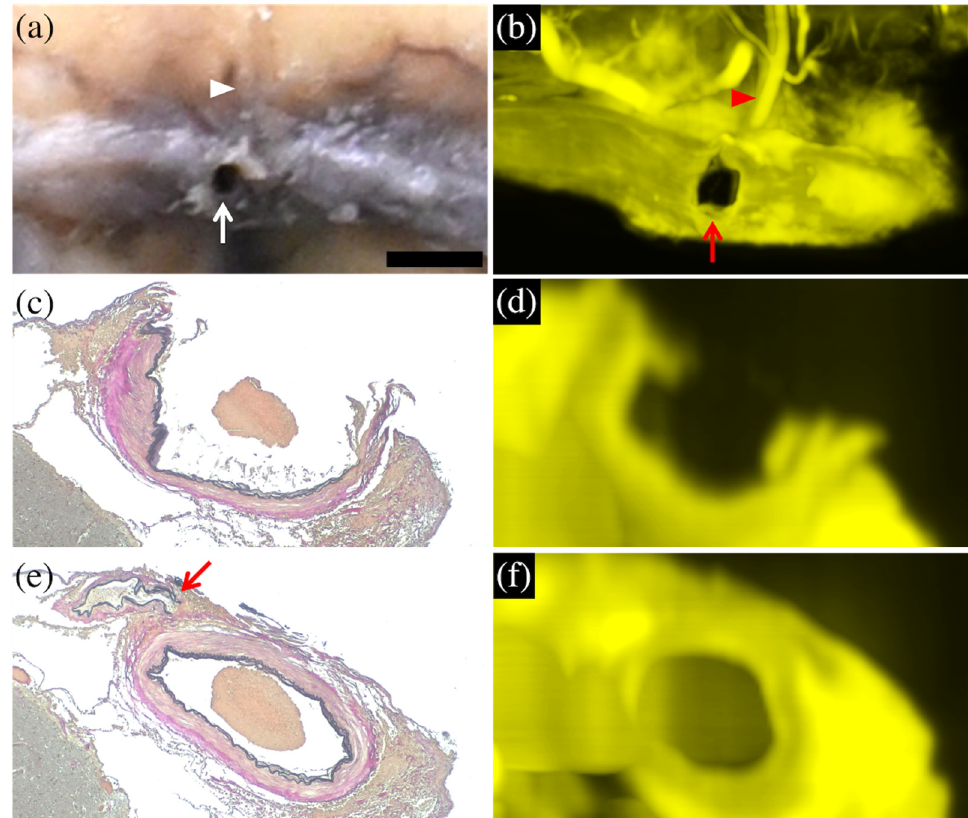
Figure 3. Comparison of macroscopic and histopathological images with CUBIC images in case 2. The enlarged macroscopic (formalin-fixed) image ( a ) shows the cortical artery with a small hole (arrow) and fine arterial branch (arrowhead), which was reconstructed and visualized in the 3D-CUBIC image ( b ). The histopathological (Elastica van Gieson staining) image ( c ) shows a wall defect in the cortical artery, which was reconstructed and visualized in the cross-sectional CUBIC image ( d ). Another histopathological (Elastica van Gieson staining) image ( e ) detected a torn end of a fine arterial branch (arrow), but this torn end is unclear in the cross-sectional CUBIC image ( f ). The bar (on the lower right side of ( a )) is equal to 1 mm for ( a , b ) and 500 μ m for ( c – f ).